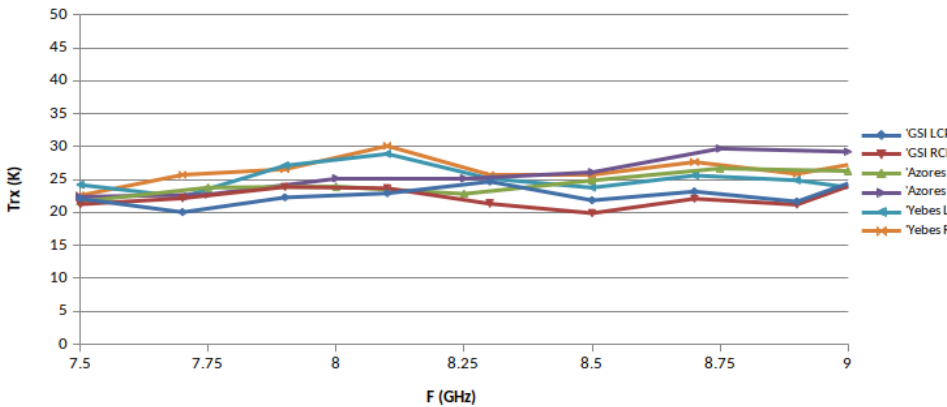
Figure 15. X-band receiver noise temperatures.